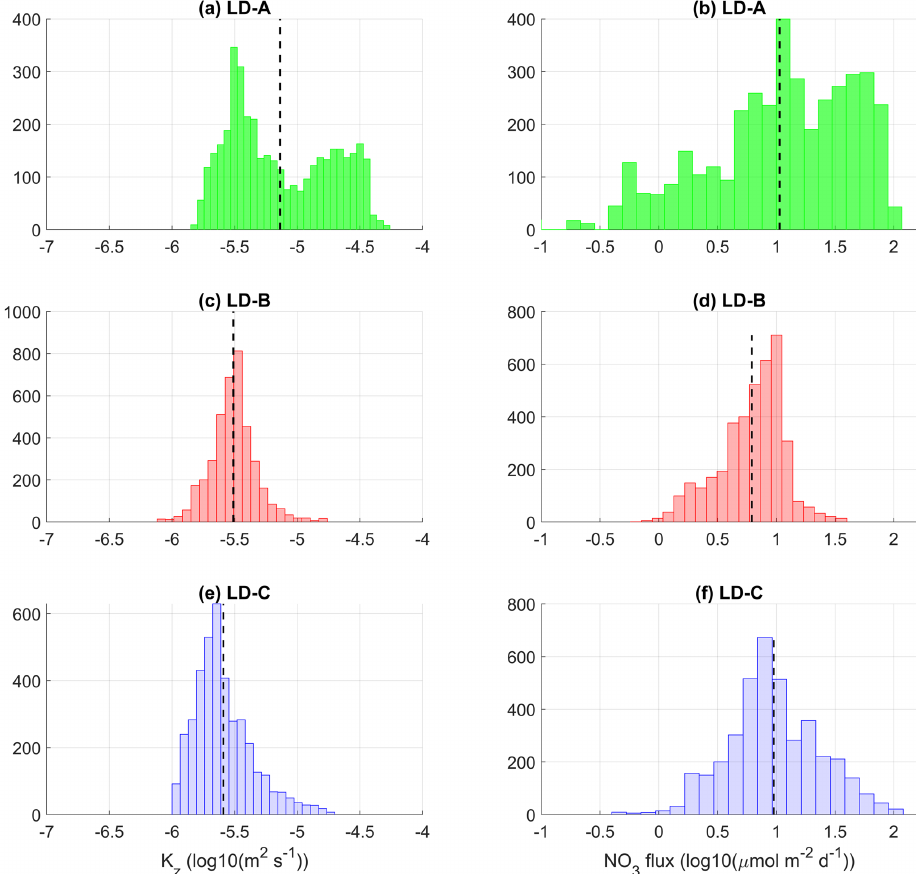
Figure 12. Histograms of K z (a, c, e) and nitrate turbulent diffusive flux (b, d, f) at long-duration stations LD-A, LD-B, and LD-C around the top of the nitracline. The top of the nitracline is defined by the isopycnal, ρ NO , with density values taken from Caffin et al. (2018), 3 + 3 × 10 − 2 kgm − 3 , of a typical vertical extension equal to 3–4m, was chosen Table 4. A density interval of the upper bound equal to ρ NO 3 for the statistics. The mean value is shown in each subpanel with a dashed